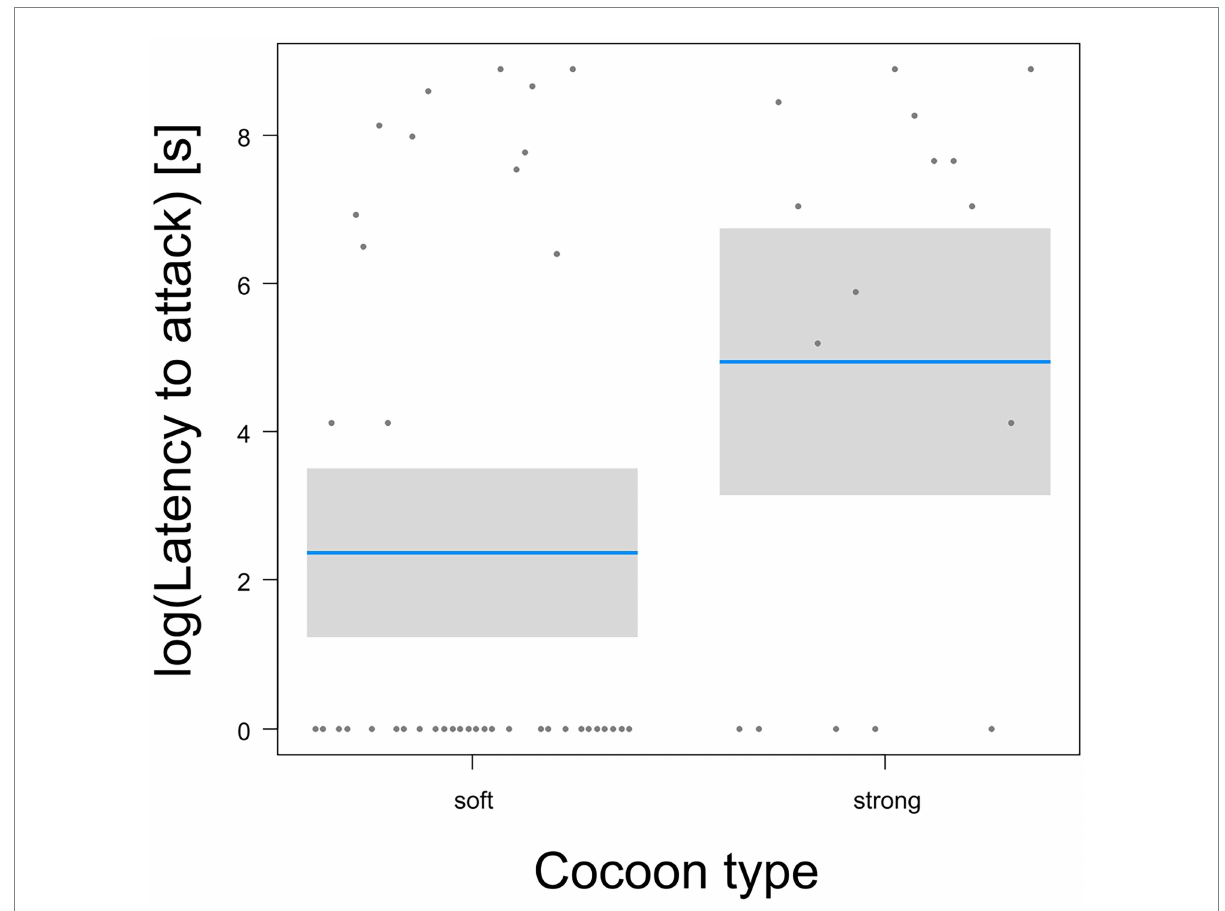
FIGURE 5 Comparison of latency to attack (on logarithmic scale) protected pupas between two cocoon types. Blue lines are estimated means, gray bars are 95% confidence intervals of the